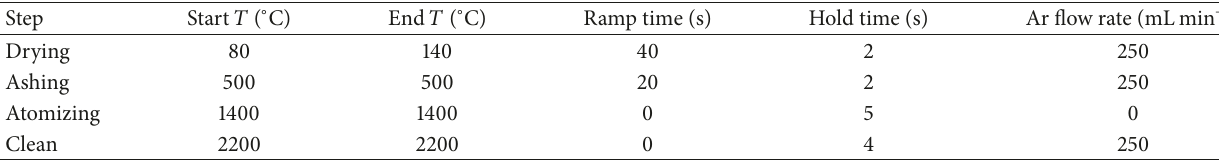
Table 1: The temperature program of graphite furnace